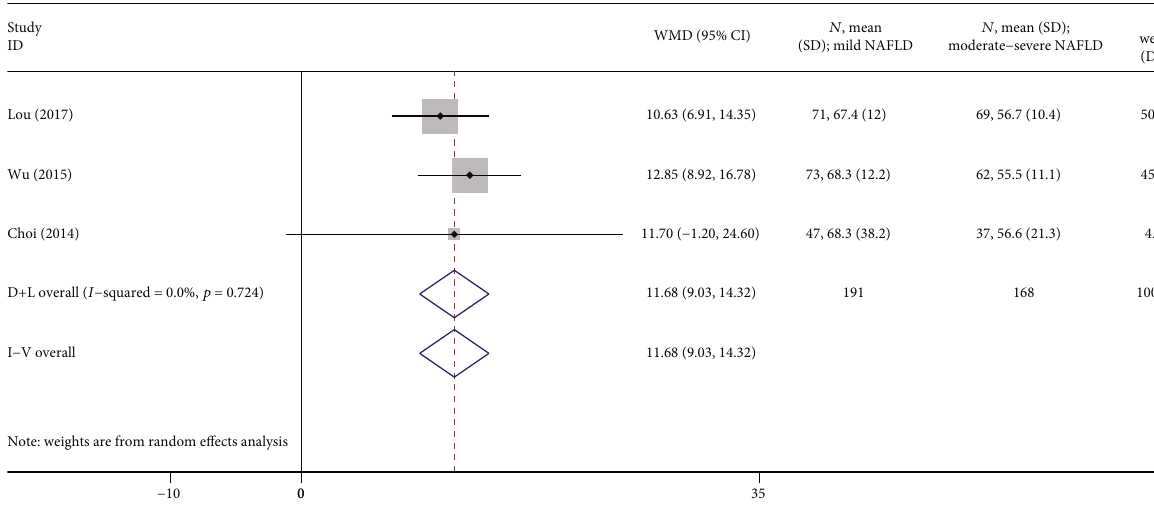
Figure 5: Forest plot analyzing the circulating irisin levels between the mild NAFLD group and the moderate-severe NAFLD